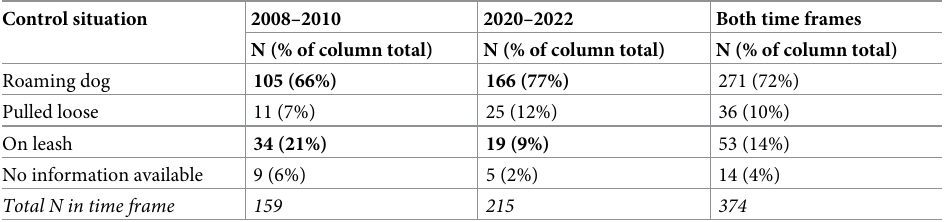
Table 6. Descriptive data on dog owners’ dog control situation, at biting incidents leading to confiscation of 374 dogs. Descriptive data on dog owners’ dog control situation, at biting incidents leading to confiscation of 374 dogs, presented as counts and as % of column total for a first time frame (2008–2010), a second time frame (2020-mid-May 2022) and overall for both time frames. The dog’s roaming applied significantly more so to these situations in the sec- ond time frame than the first ( χ 2 = 16.5, P < 0.001, df = 3, and for pairwise comparisons see S1 Appendix in S1 File).